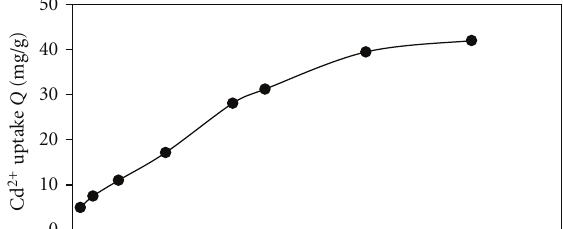
Table 2: Langmuir and Freundlich parameters for the adsorption isotherms of adsorbent for Cd(II) ion. Langmuir Freundlich Biosorbent b R 2 k n R 2 Q max Dried biomass of 27 . 03 ± 7 . 50 Oscillatoria sp.